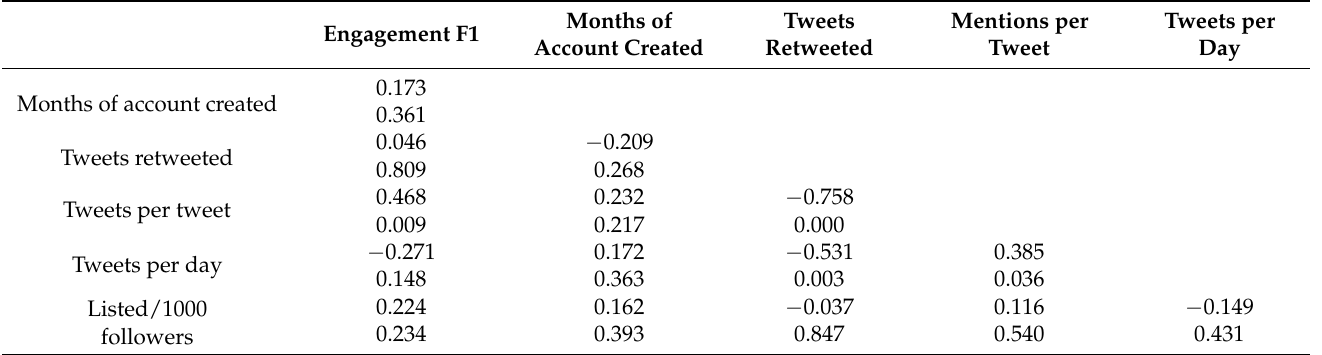
Table 4. Pearson’s correlation coefficient.